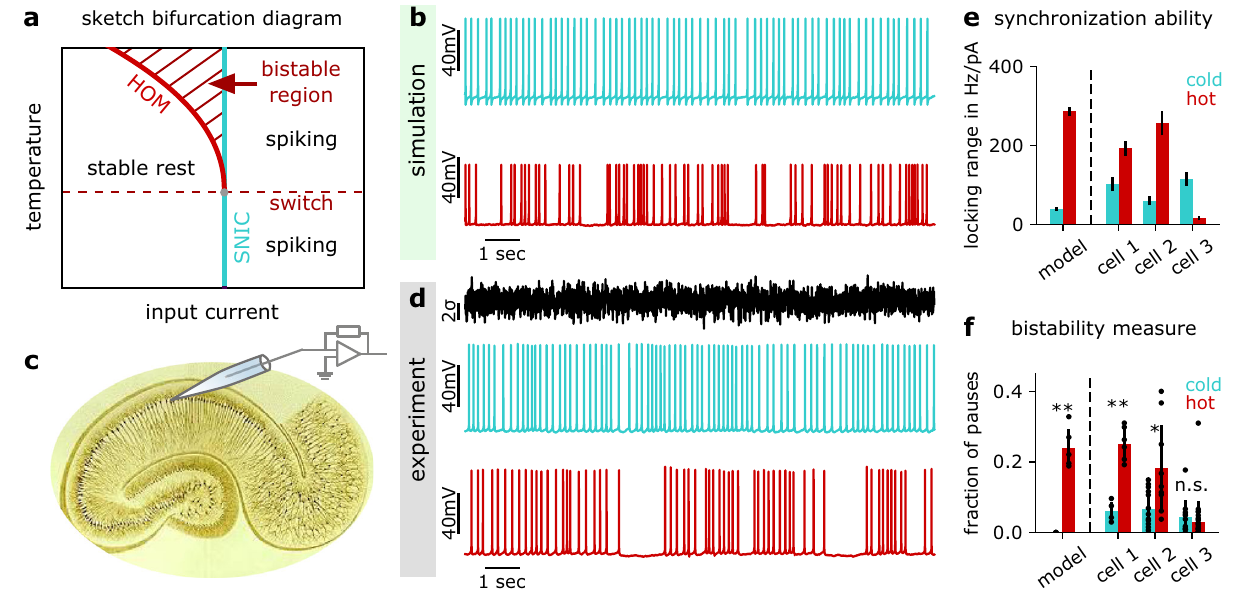
Fig. 3 Experimental hallmarks of the critical transition induced by a temperature rise. a The temperature-dependent bifurcation diagram shows a region of bistability above the critical temperature (shaded area). b Neuron model responses to a noisy current for SNIC and homoclinic spiking (blue and red traces, respectively). At the warmer temperature (homoclinic fi ring), the model exhibits a characteristic pattern of intermittently interrupted fi ring arising from the bistability. c Schematic of the recording site. d Experimental voltage traces in a hippocampal CA1 neuron at two different temperatures (blue 32.3 °C, red 37.7 °C) when stimulated with a noisy current (top trace). Indeed, at the elevated temperature, irregular, interrupted fi ring is induced. e Locking range as an indicator of synchronization ability at the colder and warmer temperature (blue and red, respectively for three experimental cells